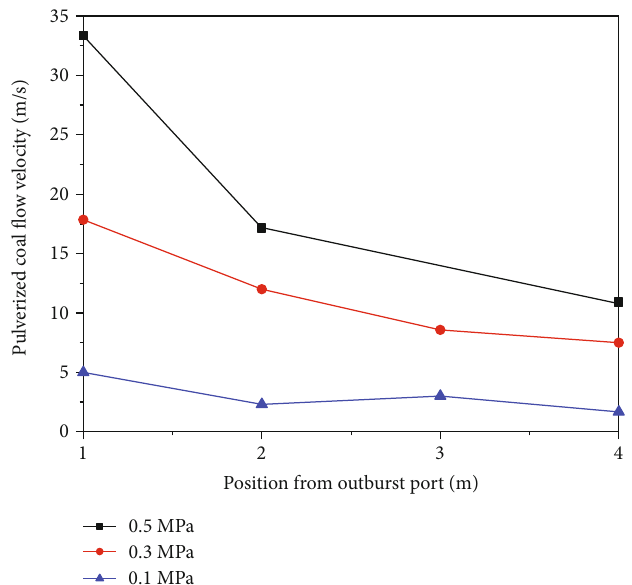
Figure 5: Relationship between pulverized coal fl ow velocity and position in outburst